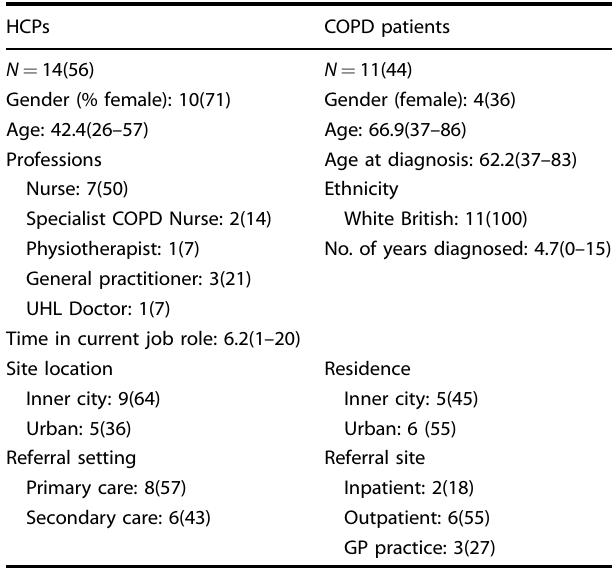
Table 1. Participant